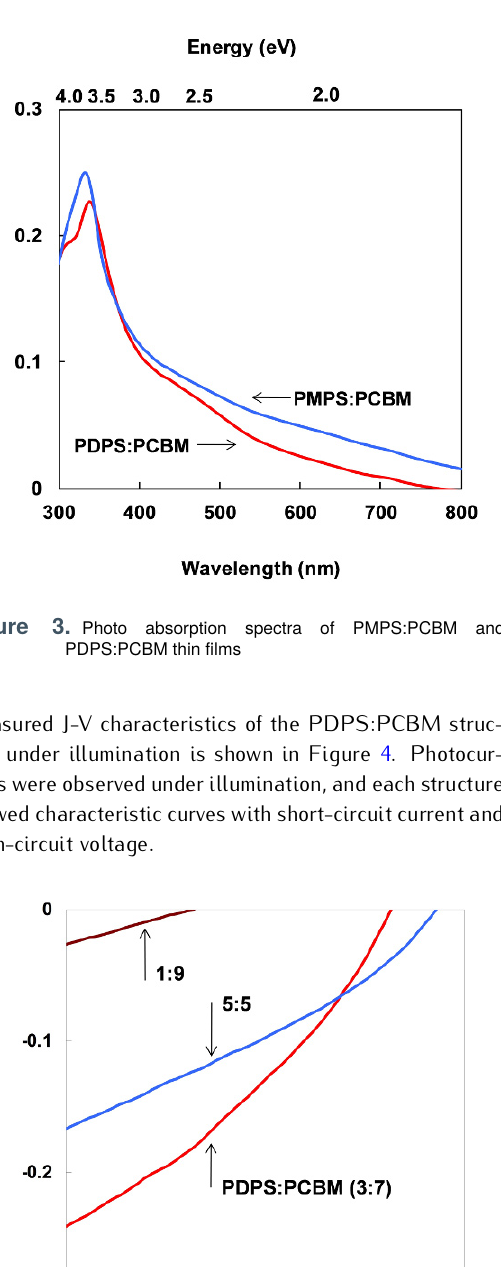
Figure 4. J-VcharacteristicsofPDPS:PCBMbulkheterojunctionso- lar cells under illumination